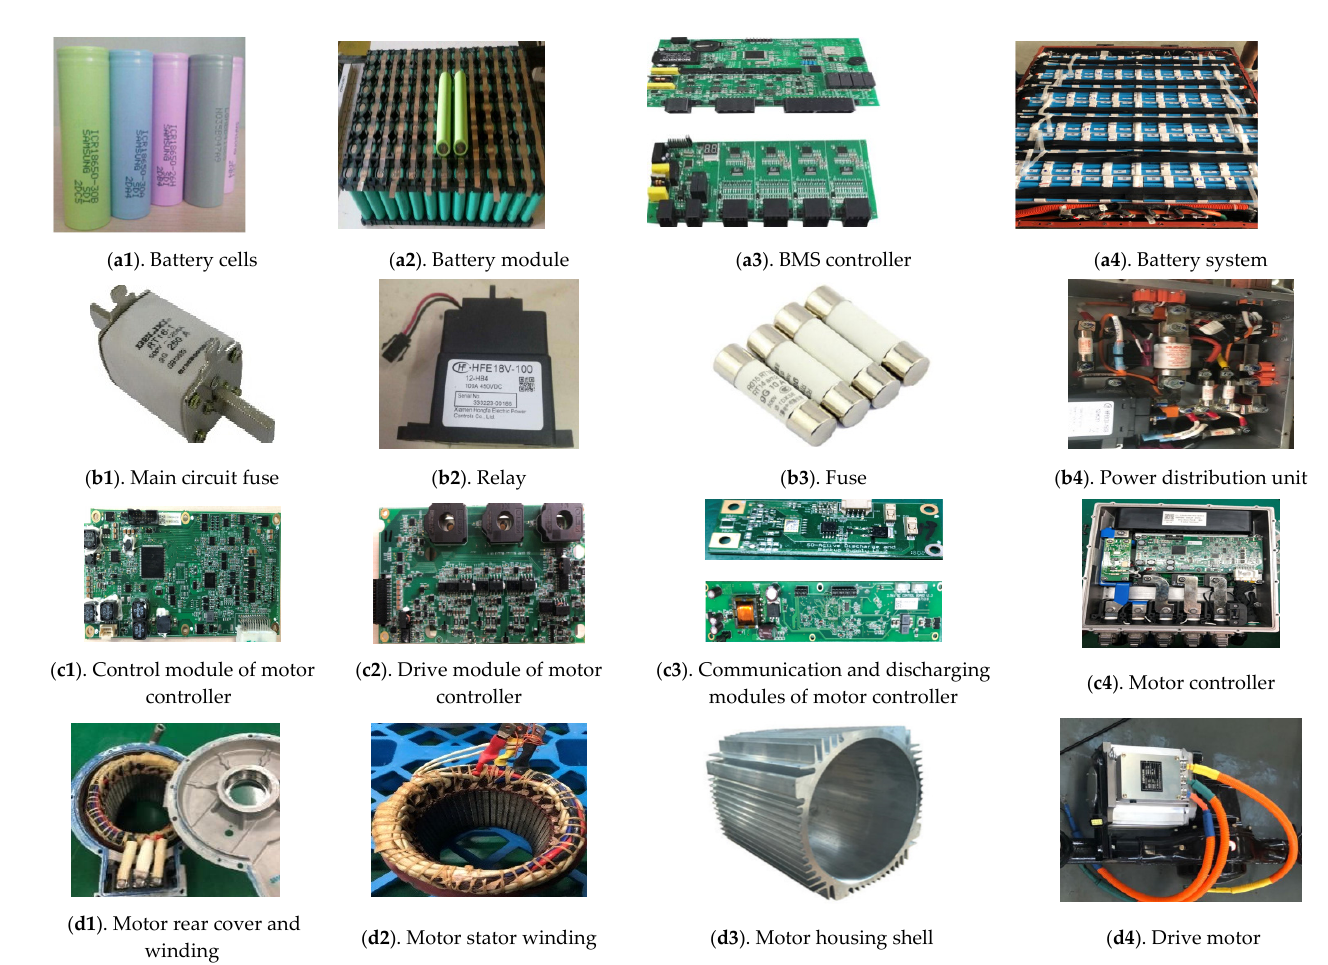
Figure A1. Components of subsystems in powertrain system.